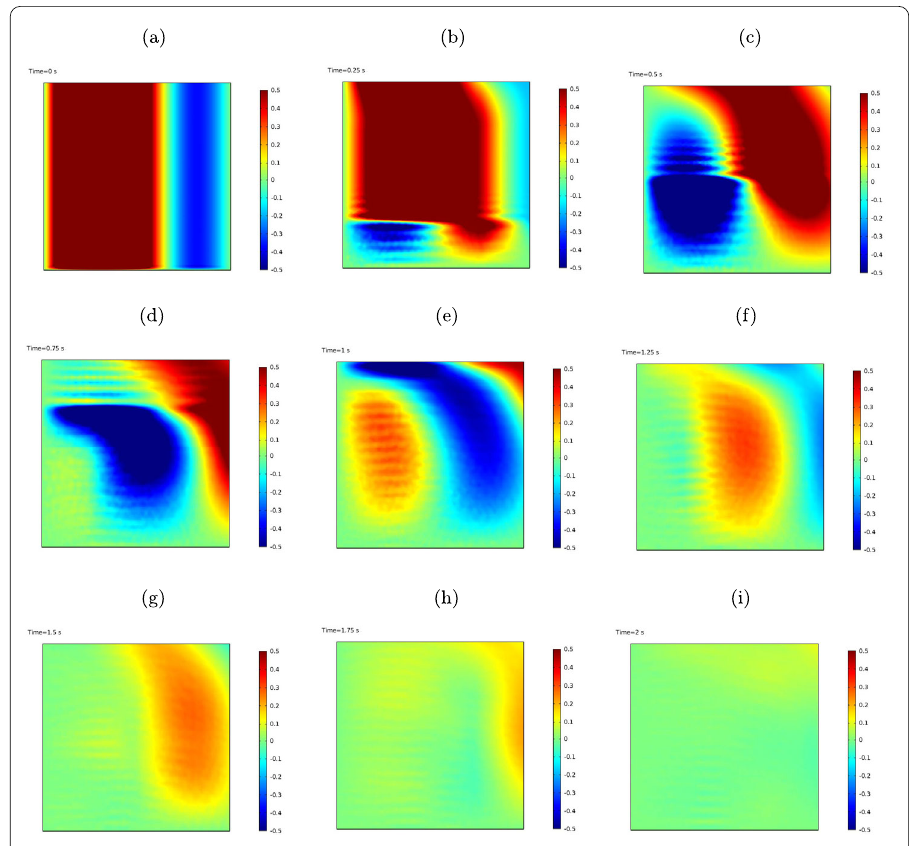
Figure 10 2-d solutions of the wave equation without delay (3.18)-(3.21), when a ( x ) = 1 and k = 1, at different times: t = 0, ... ,2